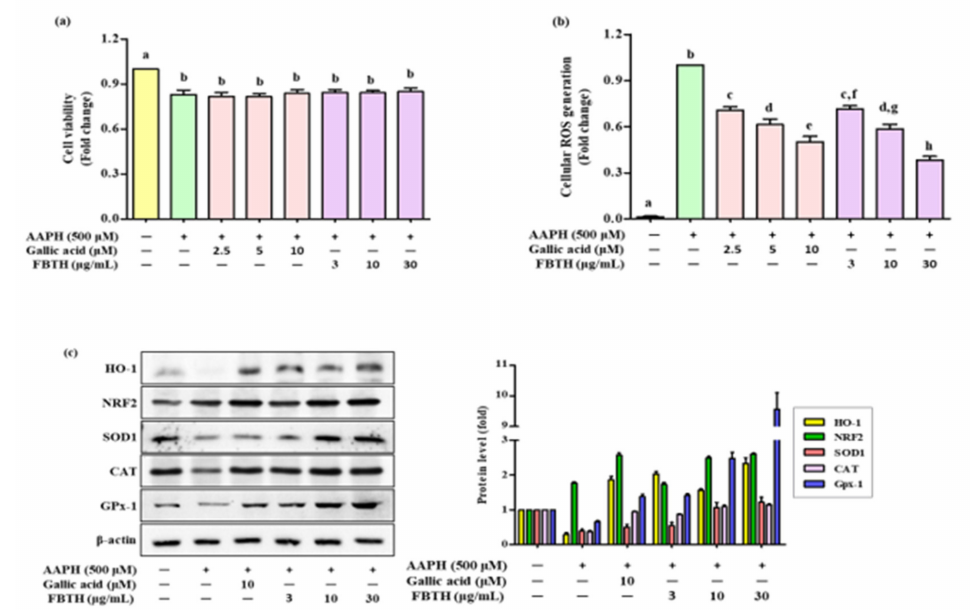
Figure 2. Effects of cellular ROS generation and antioxidant enzyme expression induced by AAPH in FBTH-treated Melan-A cells. ( a ) Cells were incubated using FBTH overnight and treated with AAPH, followed by another 24 h incubation. Cell viability was measured by MTT analysis. ( b ) Cellular ROS were measured according to the 2’,7’-dichlorofluorescin (DCF) fluorescence intensity in Melan-A cells. ( c ) Analysis of primary and phase II antioxidant and detoxifying enzymes. Melan-A cells were pretreated with 2- µ L of FBTH for 24 h. Protein expressions of phase I and phase II antioxidant enzymes analyzed by Western blotting and compared to the band intensity were also shown in the adjacent figure. Data are expressed as the mean ± SD ( n = 3). All tests were performed in triplicate. Different letters stand for statistically significant each other ( p < 0.05) performed by one-way ANOVA followed by Tukey’s test. HO-1, heme oxygenase-1; NRF2, NF-E2-related factor2; SOD-1,